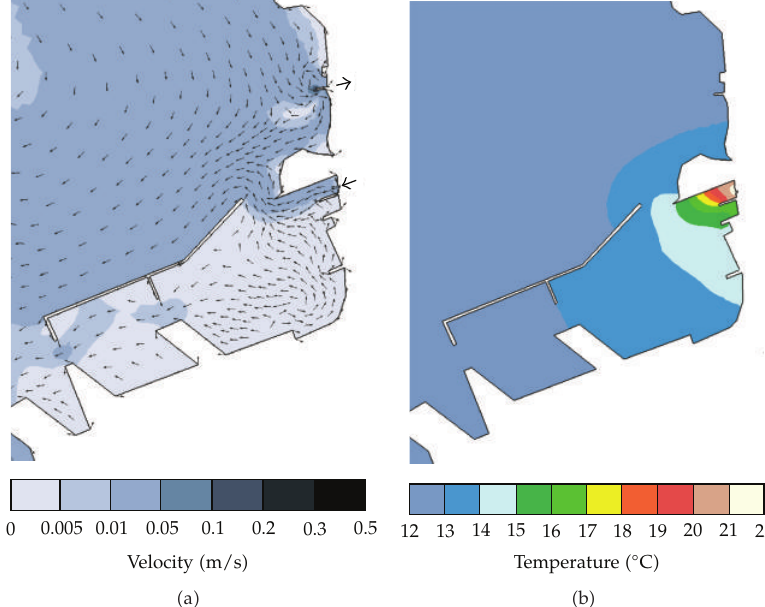
Figure 15: Velocity field and temperature field obtained with the model for the 17 June 18:30 hours with the 5th and 6th units of the Power Plan in